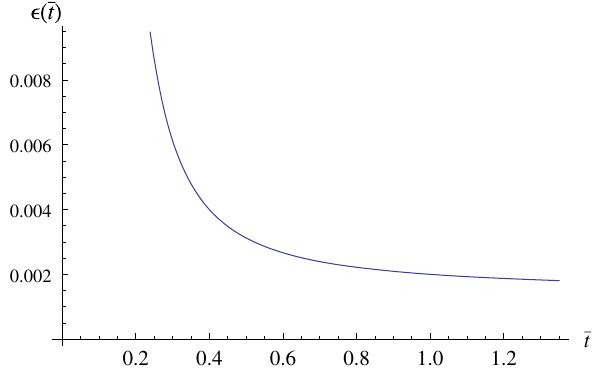
Fig. 15 Theevolutionof (cid:19)( ¯ t ) intheEinsteinframeinthecasewhenthe evolution of the universe starts from the generalized sudden singularity. For illustration it is assumed that f ( ˆ R ) = ˆ R + γ ˆ R 2 + δ ˆ R 3 , where (cid:3) (cid:4) (cid:3) (cid:4) s 2 Mpc 2 s 4 Mpc 4 γ = 10 − 9 and δ = 10 − 13 . Note that for the late km 2 km 4 time (cid:19)( ¯ t ) is constant. Time is expressed in units of s Mpc 100